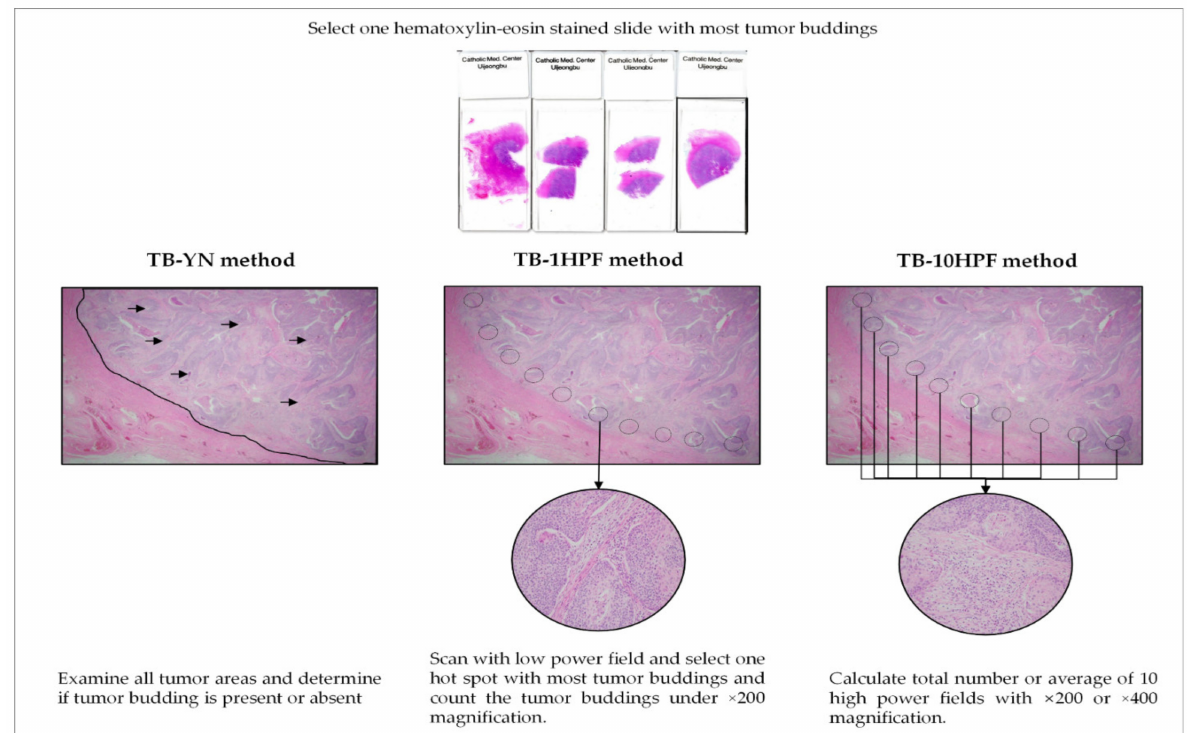
Figure 4. Description of three representative tumor budding assessment